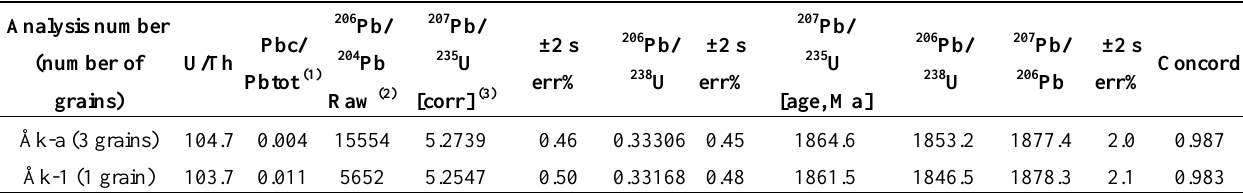
Table 2. Baddeleyite U-Pb TIMS